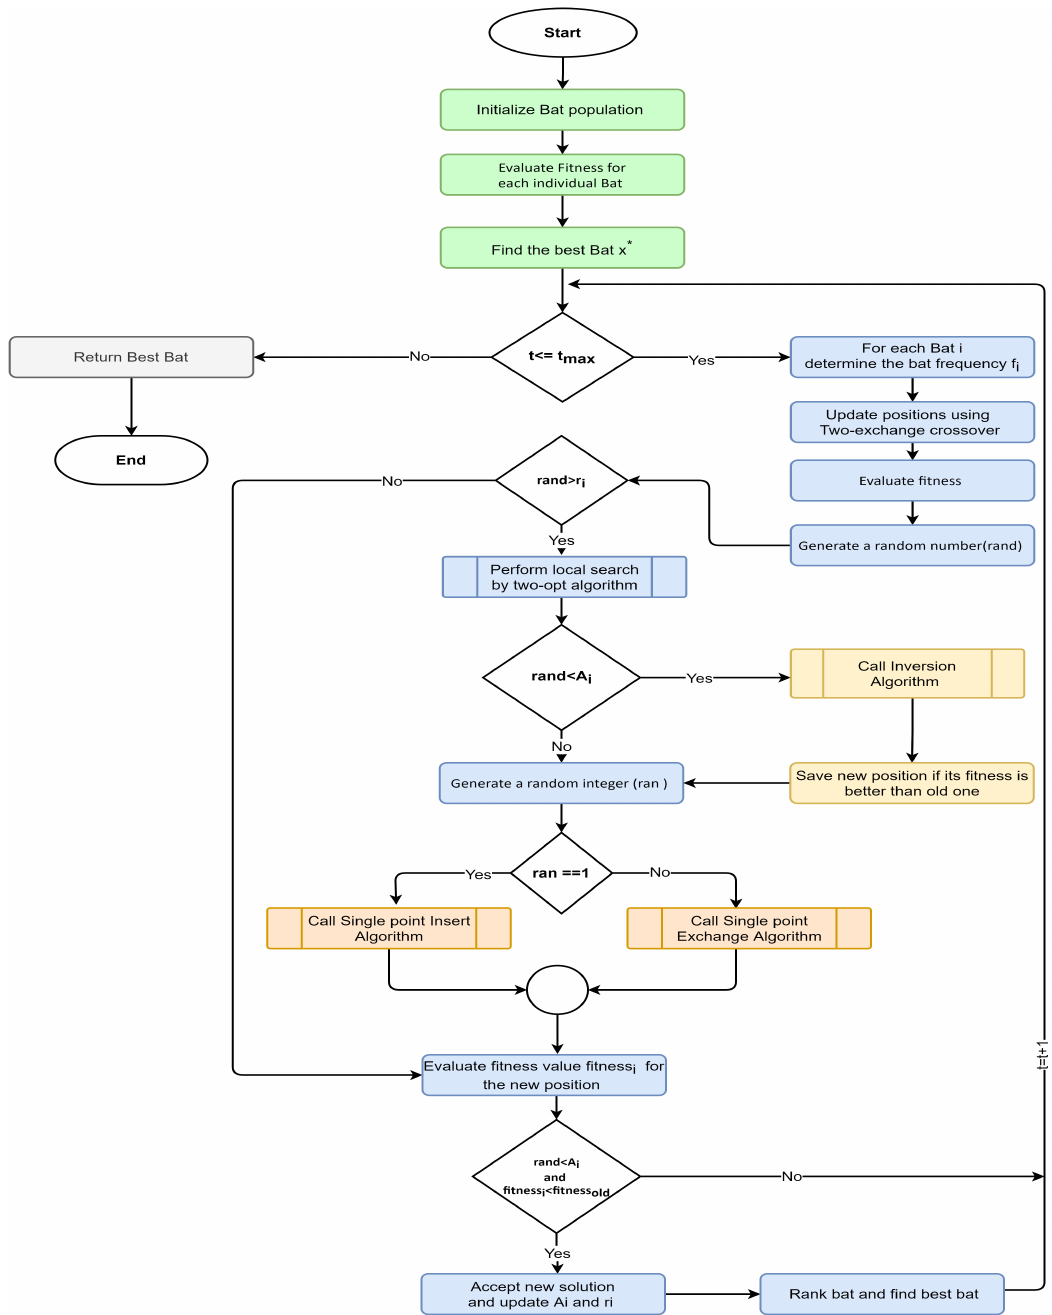
Figure 3. Flow diagram of